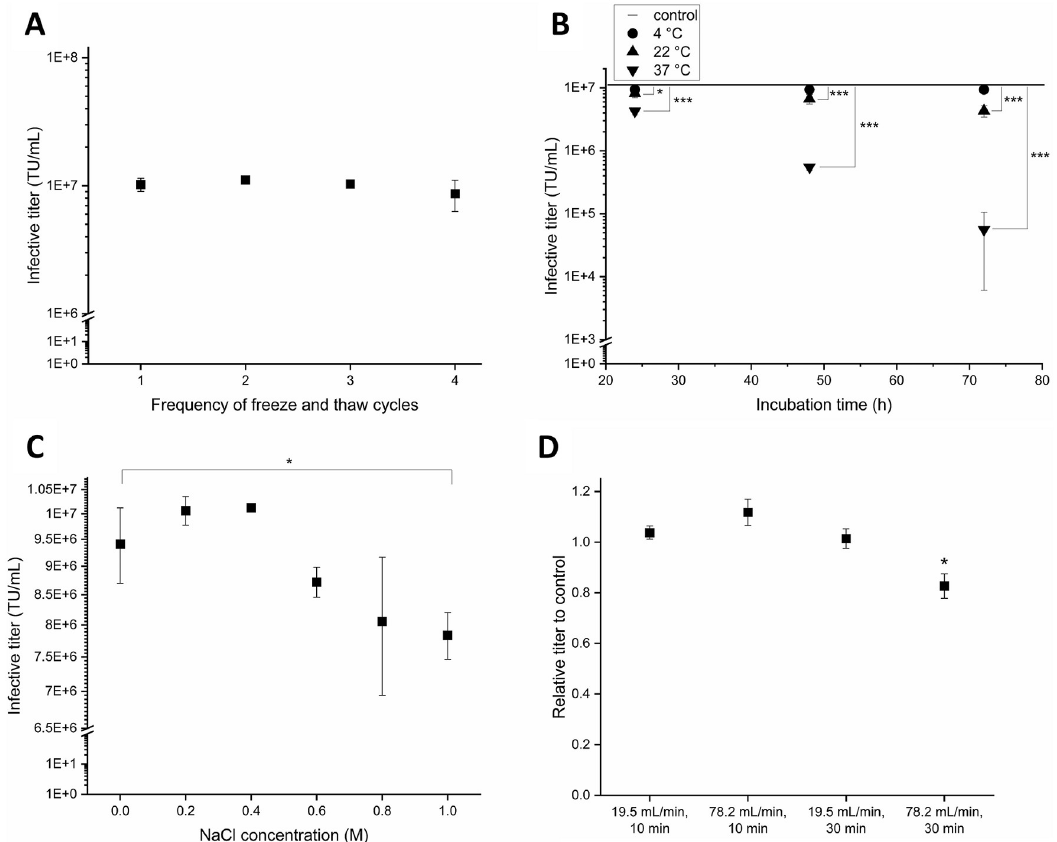
Fig 7. Investigation of external factors on lentiviral vector stability. Assessment of the influence of repeated freeze and thaw cycles (A), storage at different temperatures over time (B), control line represents non-treated LV sample, different sodium chloride (NaCl) concentrations (C) and shear stress induced by a peristaltic pump (D) on lentiviral vector (LV) infectivity. Experiments were performed in biological triplicates. Data represent the mean ± standard deviation. P-values are indicated as follows: � p � 0.05; �� p � 0.01; ��� p �